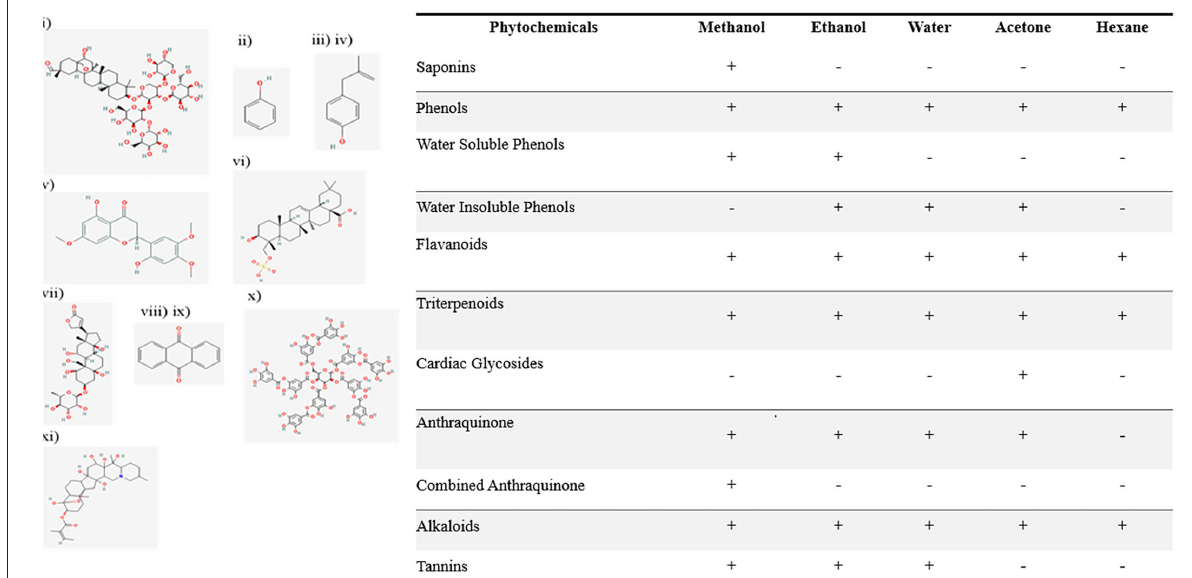
high µ g/ml concentration in methanol. Water-soluble phenols were present in all the polar solvents only. Water